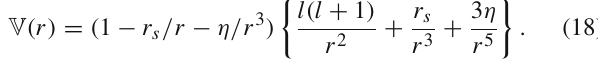
i.e., a = 0, the expression of potential V ( r ) from Eq.